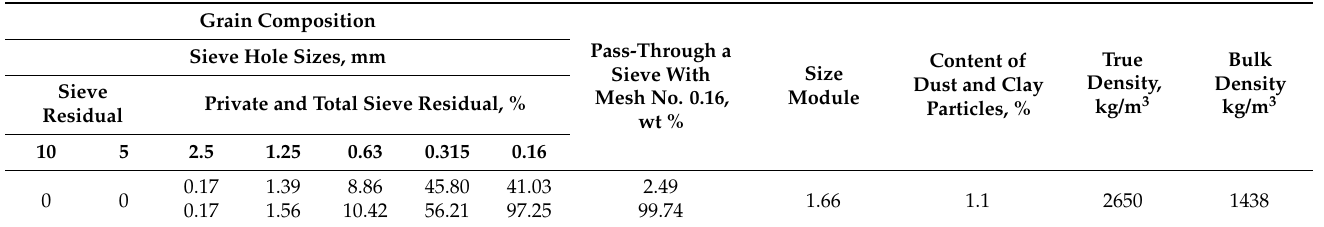
Table 1. Physical characteristics of dense fine aggregate.